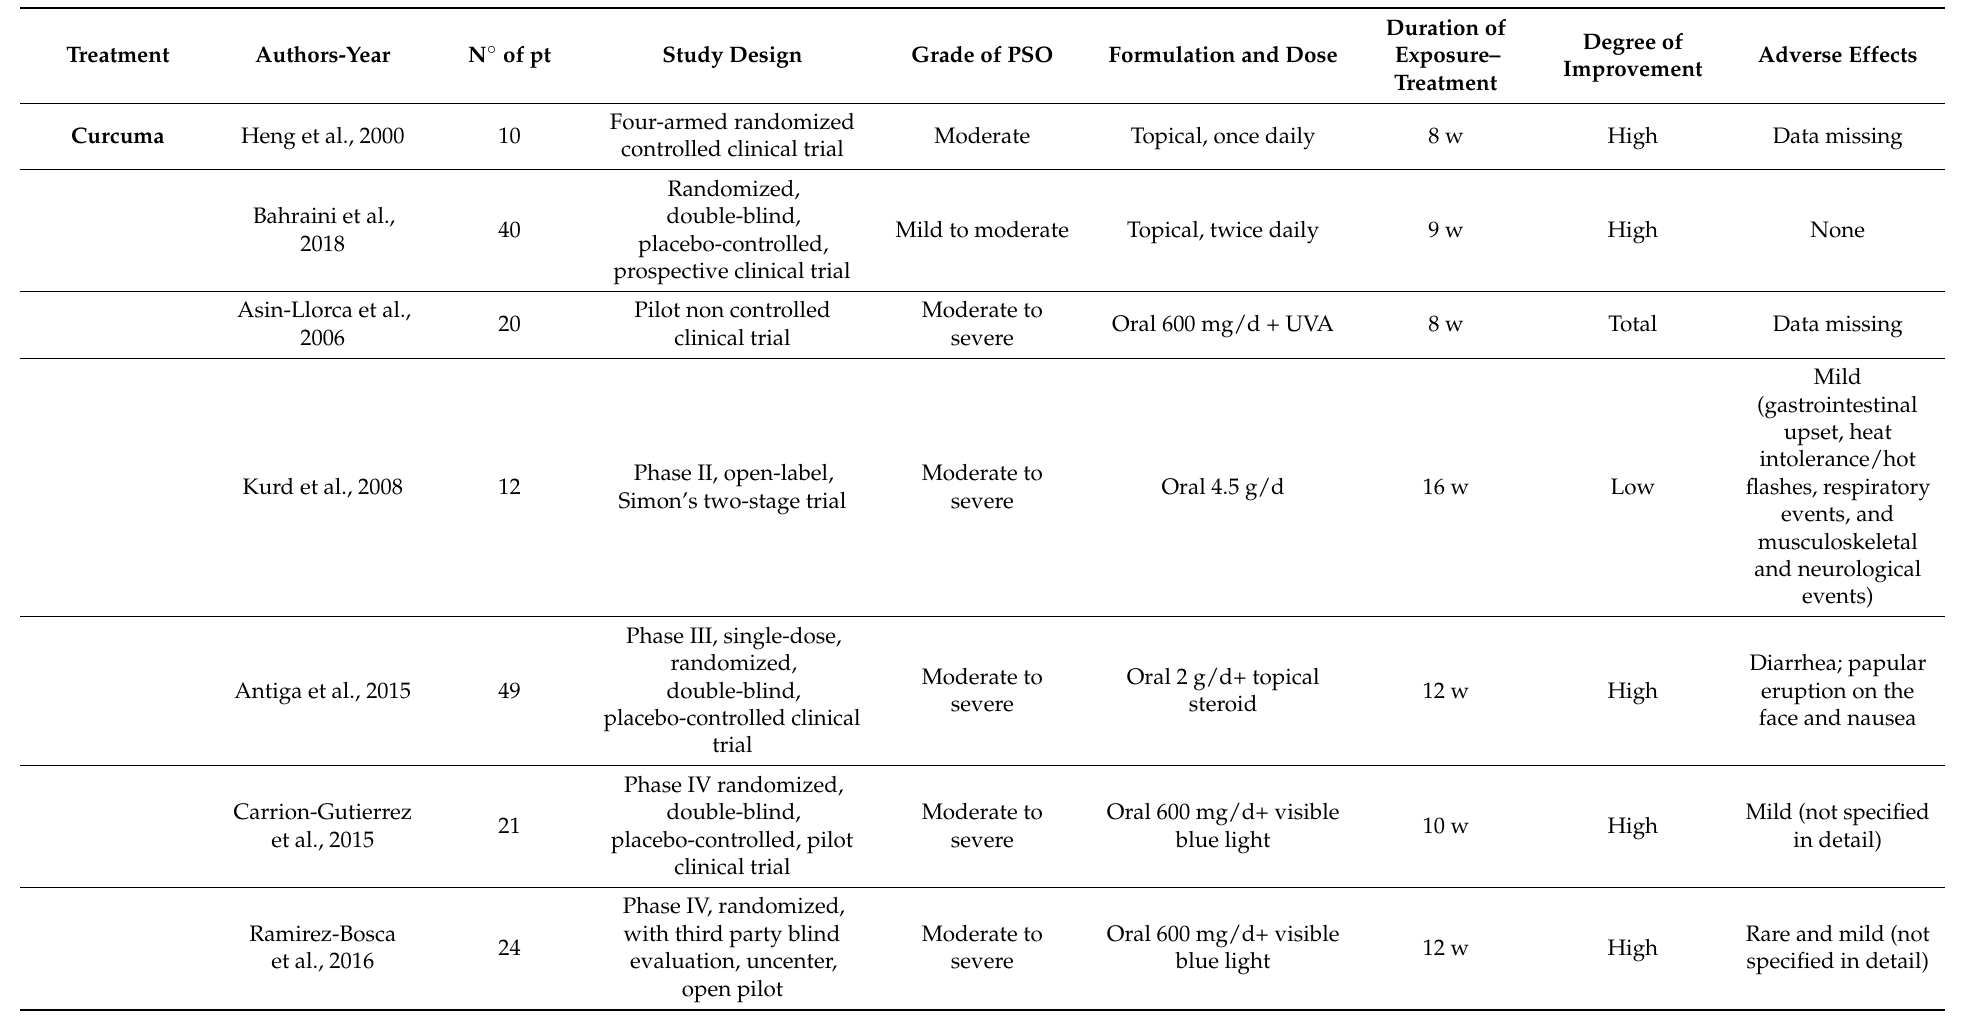
Table 1. Summary of studies on the efficacy of treatments with antioxidant potential in